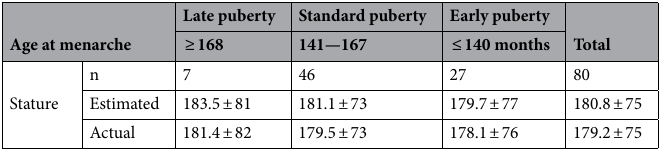
Table 6. Actual and estimated adult stature by maturity stages in female basketball players.